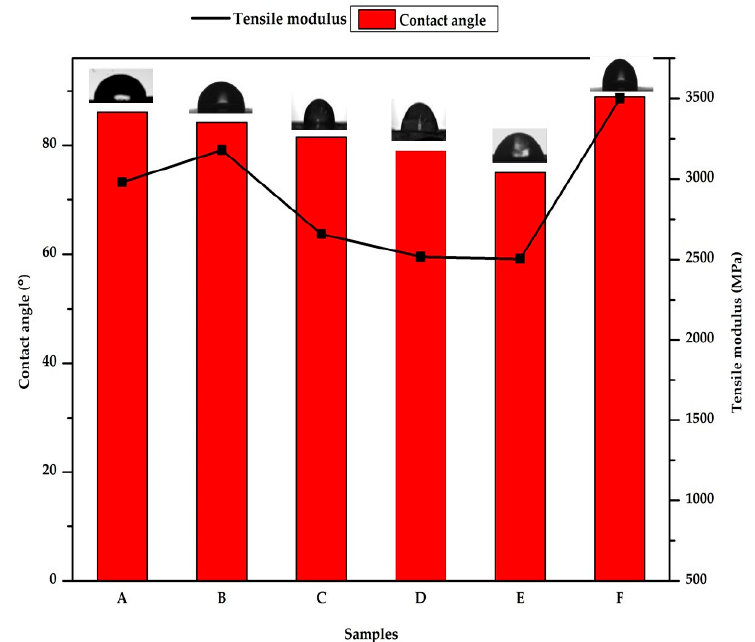
Figure 1. Tensile modulus and contact angle of samples A—92% polylactic acid (P) / 8% chitin (C); B—92% P / 6% C / 2% starch (S); C—92% P / 4% C / 4% S; D—92% P / 2% C / 6% S; E—92% P / 8% S; F—100% P.